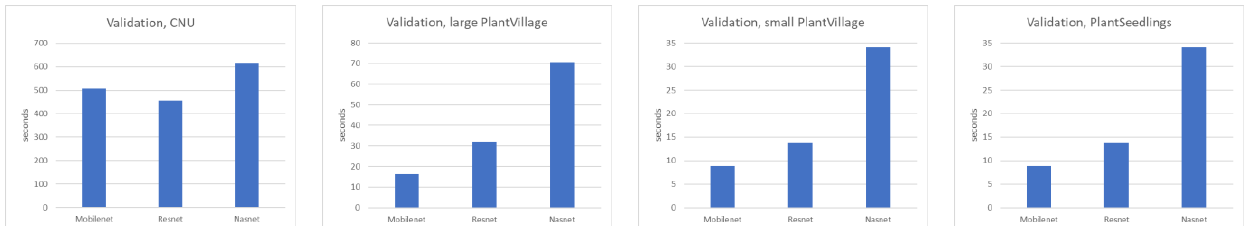
Figure 9. Total validation time of each of the models on the four different datasets.